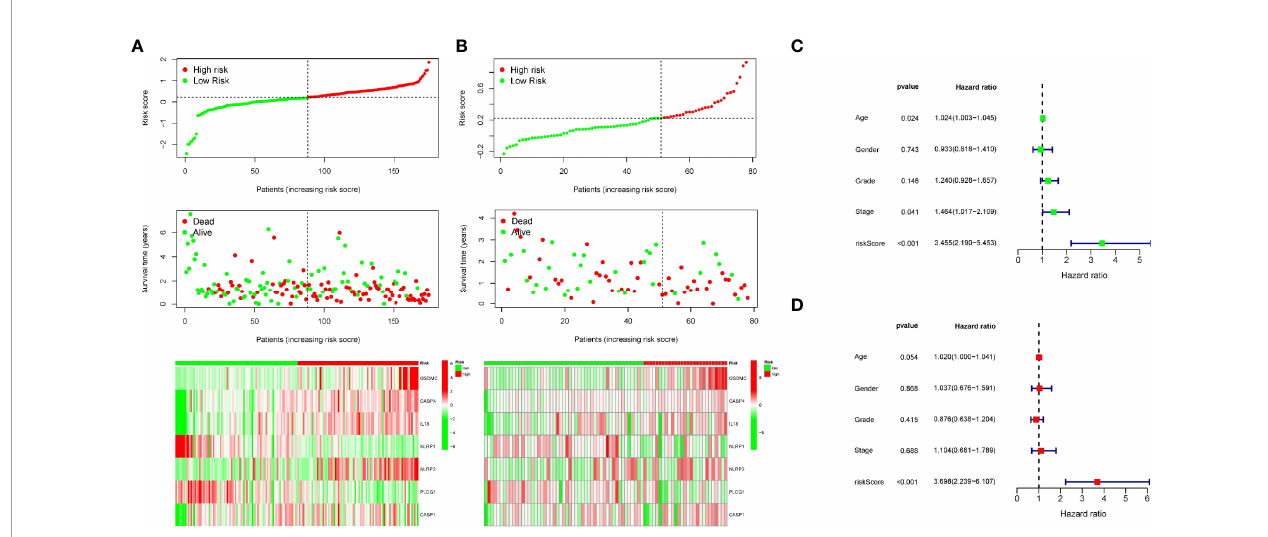
FIGURE 5 | Univariate and multivariate Cox regression analysis of clinical features and the signature. (A, B) The distribution of risk score (upper), survival time (middle) and gene expression of PRGs (below) in TCGA and ICGC cohort. (C) Univariate Cox regression analysis for the prognostic signature. (D) Multivariate Cox regression analysis for the prognostic